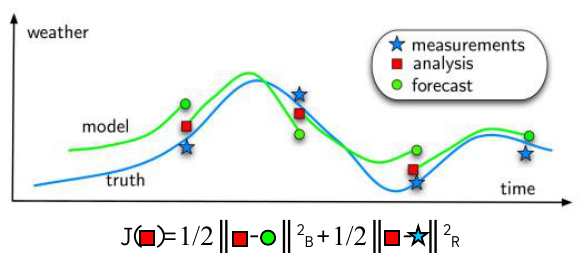
Figure 2. A simple example of distances minimization (weather forecast and estimation application) [Thual, 2013].